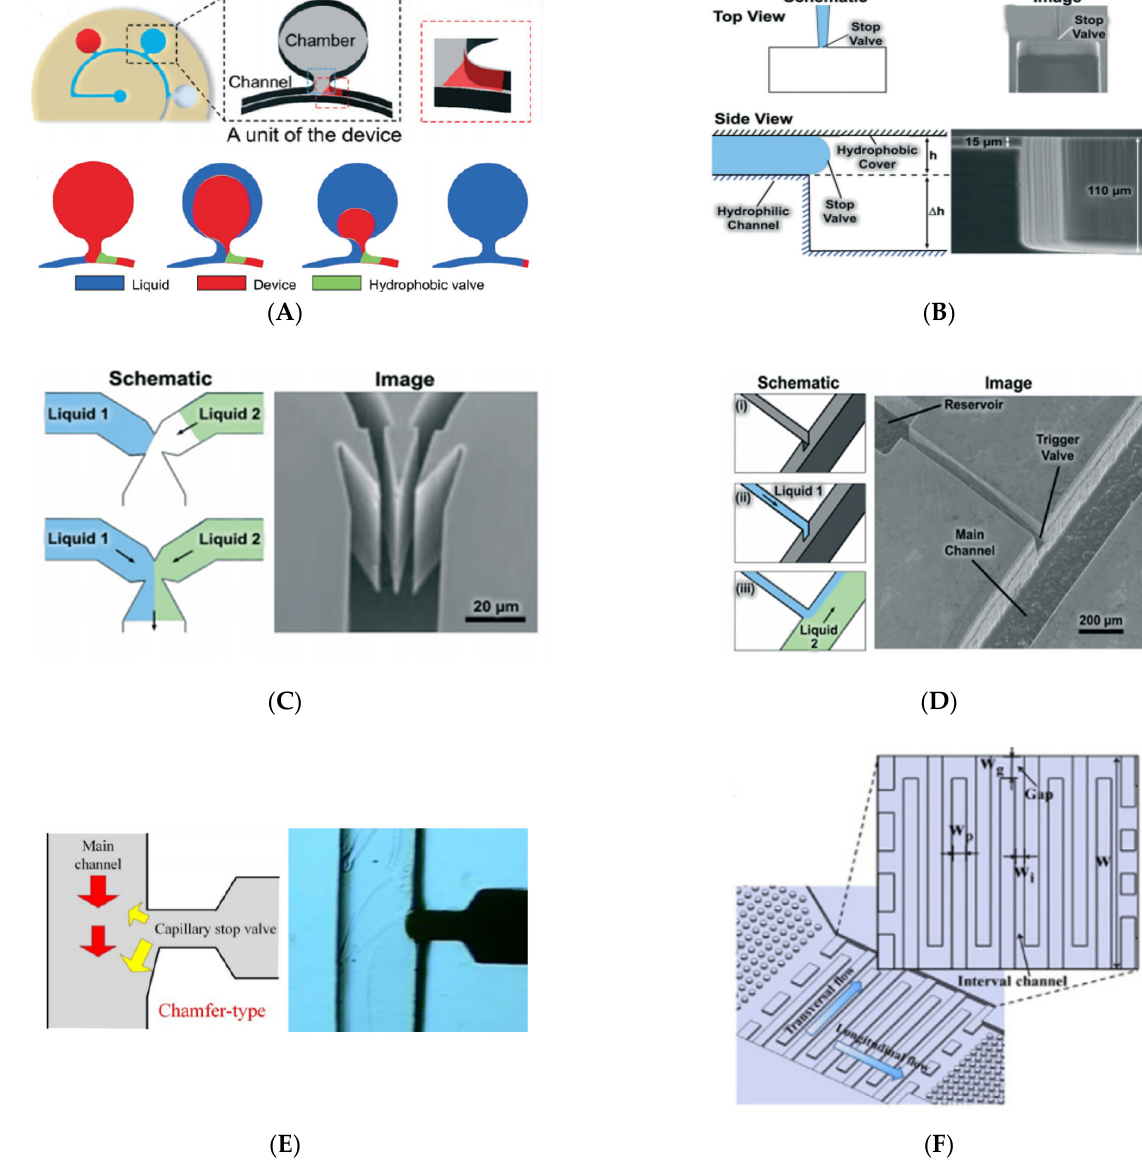
Figure 3. Structures of CPCV. ( A ) Surface treatment type stop valve. Reprinted with permission from [45]. Copyright 2020 Royal Society of Chemistry. ( B ) Cross section expanding type stop valve. ( C ) Single layer trigger valve. ( D ) Stair-step trigger valve. (( B – D ) reprinted with permission from [14]. Copyright 2018 Royal Society of Chemistry.) ( E ) Chamfer-type trigger valve. Reprinted with permission from [15]. ( F ) Comb-like delay valve. Reprinted with permission from [18].